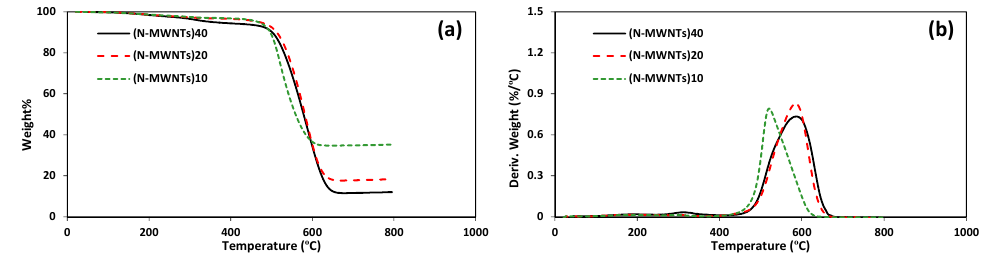
Figure 5. ( a ) TGA, ( b ) DTA plot of N-MWNTs grown over different ratios of Fe catalyst.